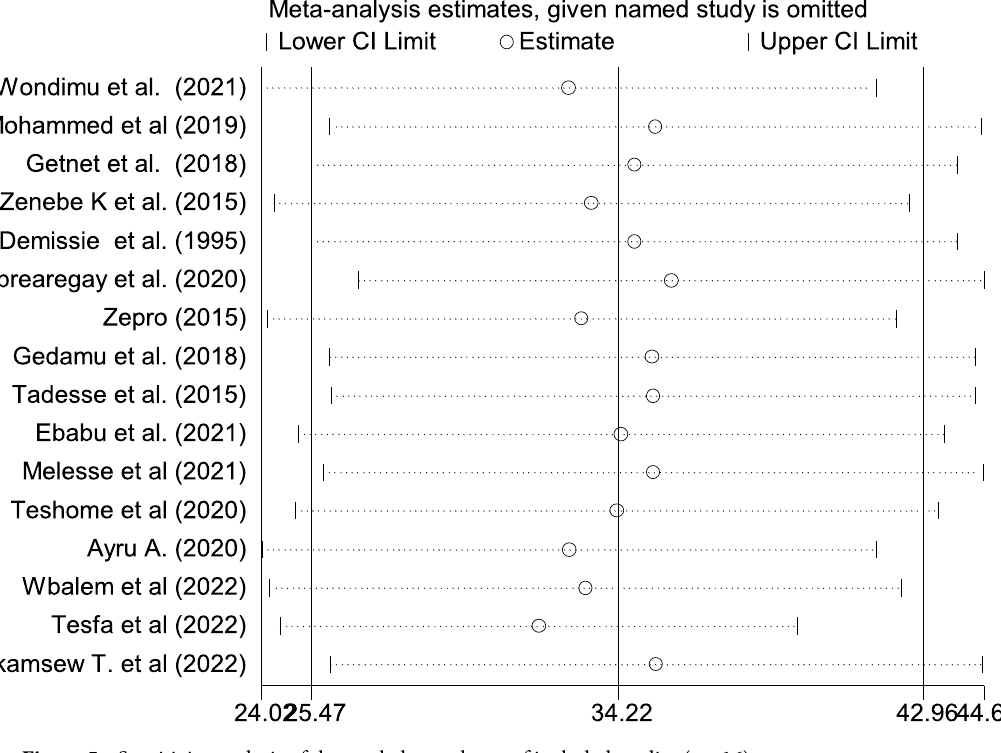
Figure 5. Sensitivity analysis of the pooled prevalence of included studies (n =